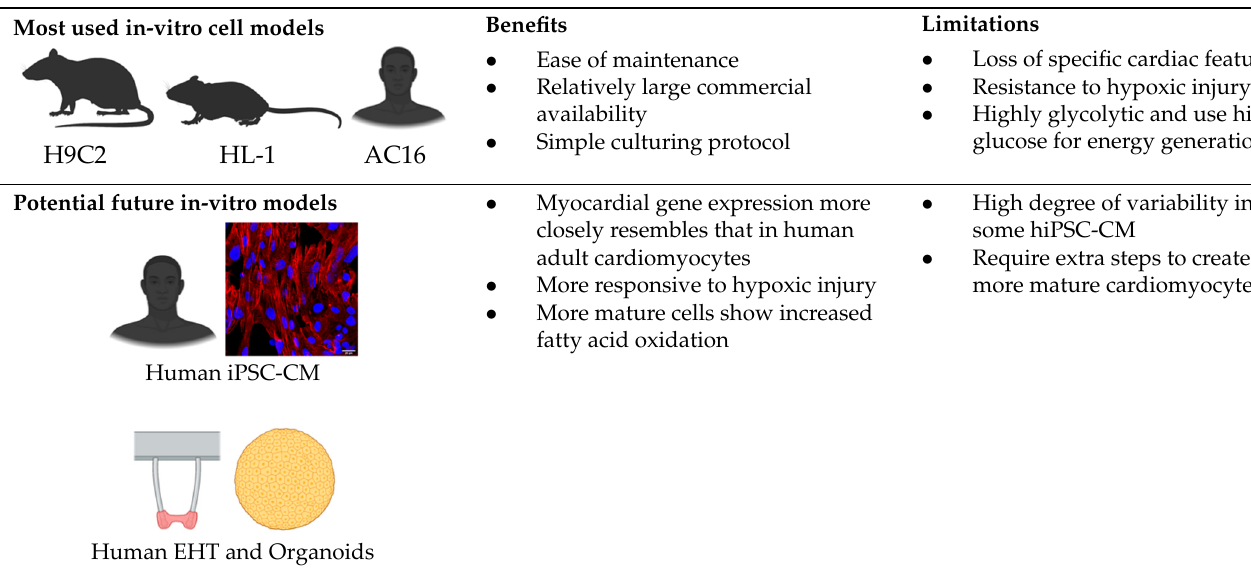
Table 2. Different in vitro cell models to study insulin resistance in cardiomyocytes.